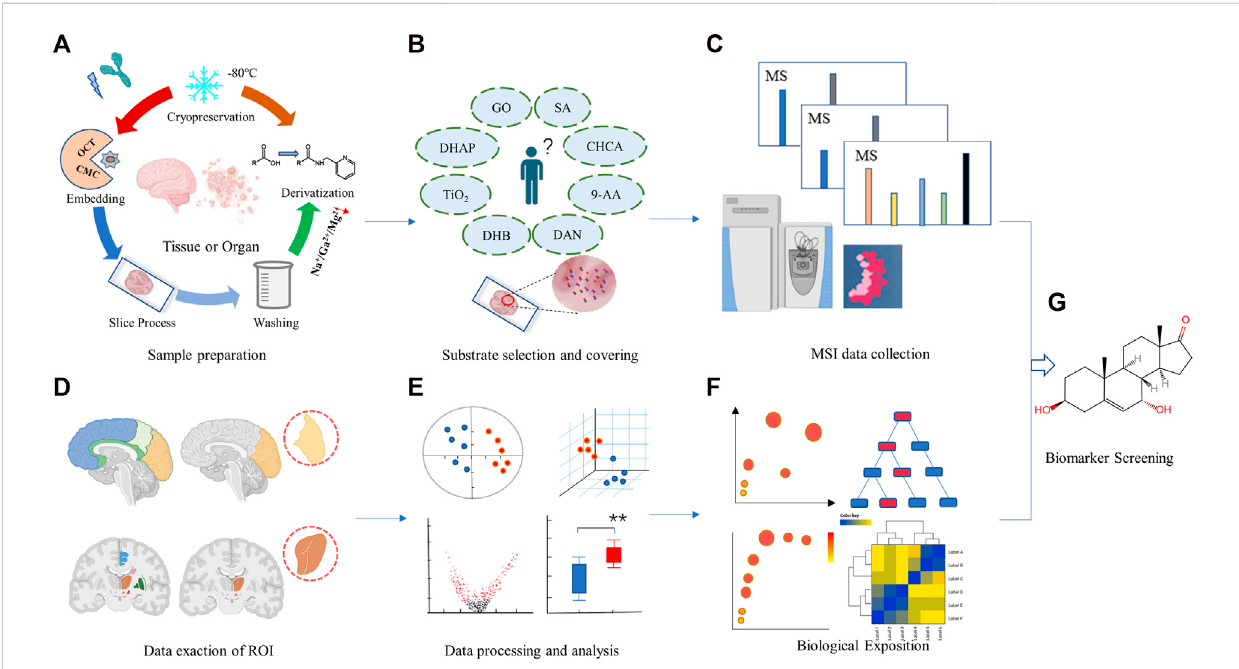
FIGURE 1 Analysiswork fl owforatypicalspatialmetabolomics.Itmainlycoverstwoparts:massspectrometryimaging (A – C) andmetabolomicsstudies (D – F) . Sample collection and pretreatment for mass spectrometry imaging (A) , selection and embedding of matrix (B) , data collection and analysis for mass spectrometry imaging (C) , Data exaction of ROI (D) , data processing and analysis (E) , and biological function description (F) . Biomarker screening and discovery (G) . The fi gure is created by BioRender and